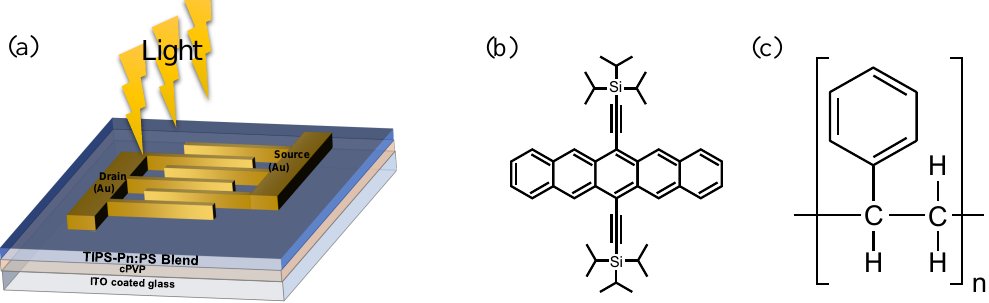
Figure 1. ( a ) Schematic illustration of the fabricated TFT under light irradiation and the chemical structure of ( b ) TIPS-Pn and ( c ) PS.